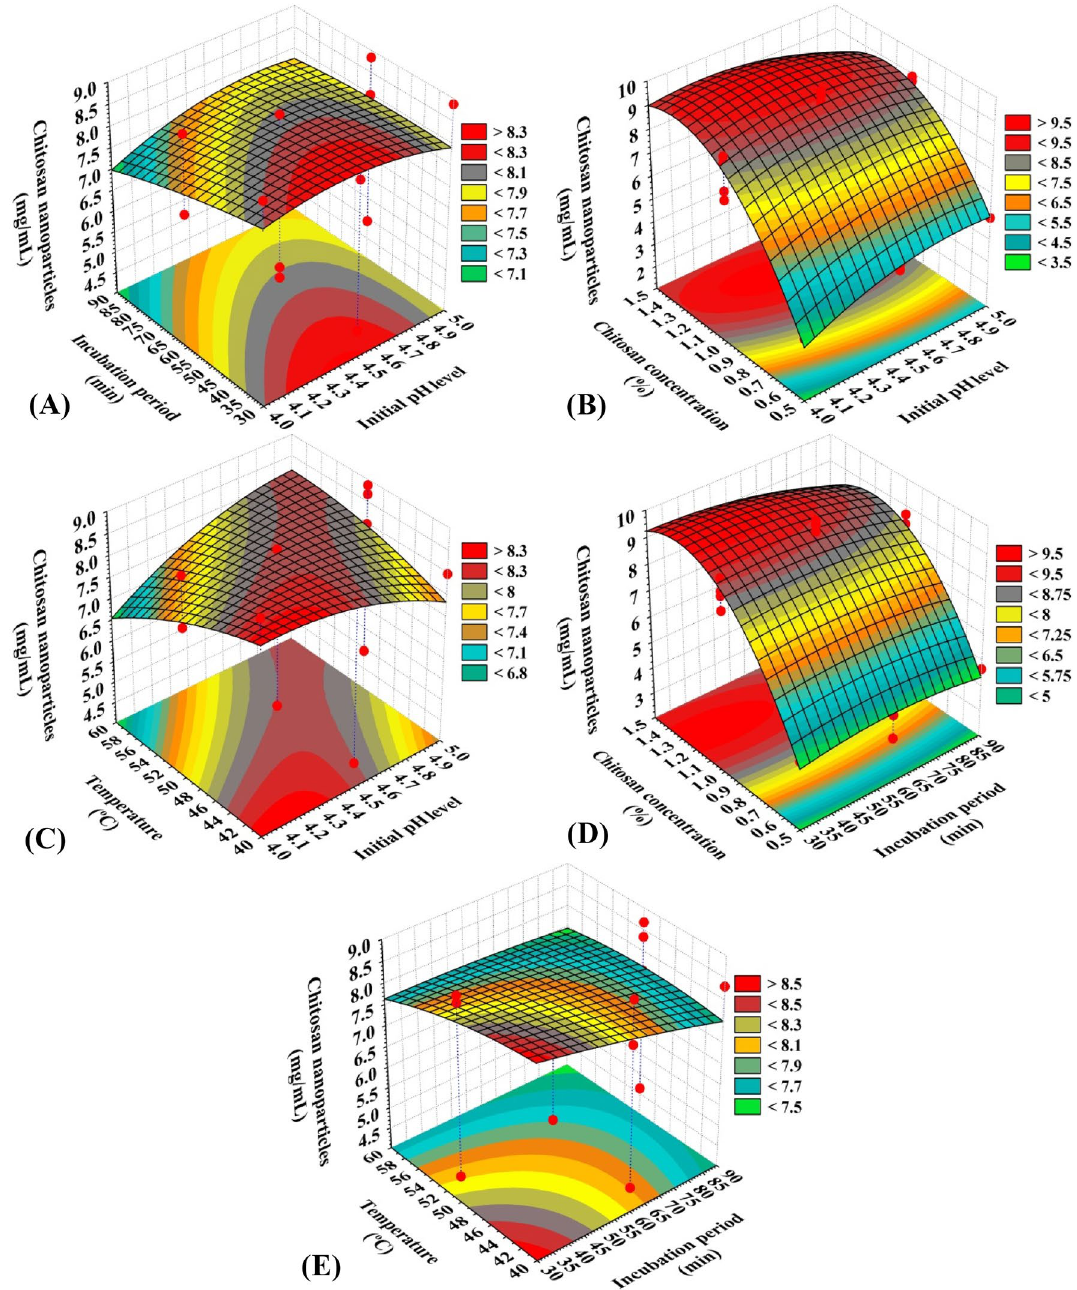
Figure 2. Three-dimensional surface plot for chitosan nanoparticles biosynthesis using Eucalyptus globulus Labill leaves